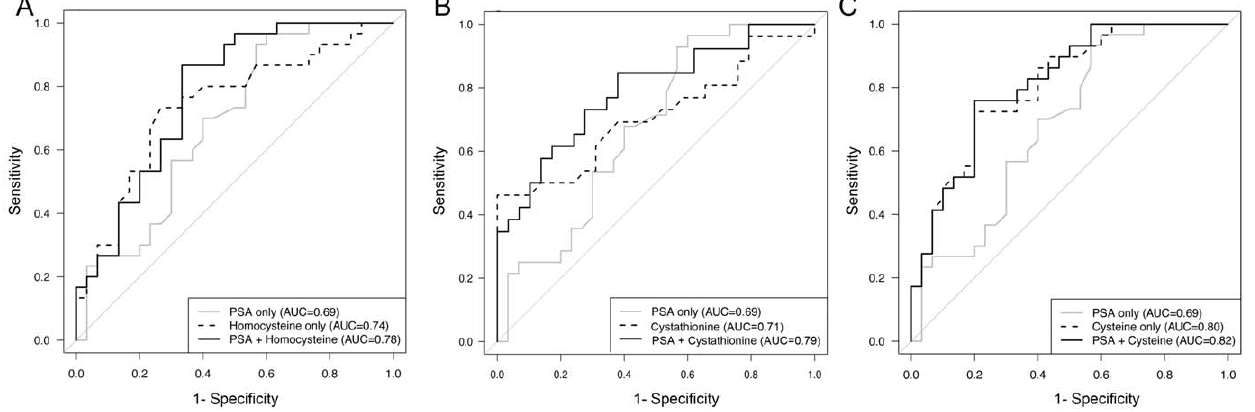
Figure 2. Receiver Operator Curve (ROC) for a statistical model that can be used to predict recurrence of prostate cancer based on serum derived variables. Serum PSA is compared to the added value of serum (A) homocysteine, (B) cystathionine, and (C) cysteine. In the ROC curve the probability with greater Area Under the Curve (AUC) support increased specificity and sensitivity over random guess, represented by the dotted diagonal line. doi:10.1371/journal.pone.0022486.g002 PLoS ONE |